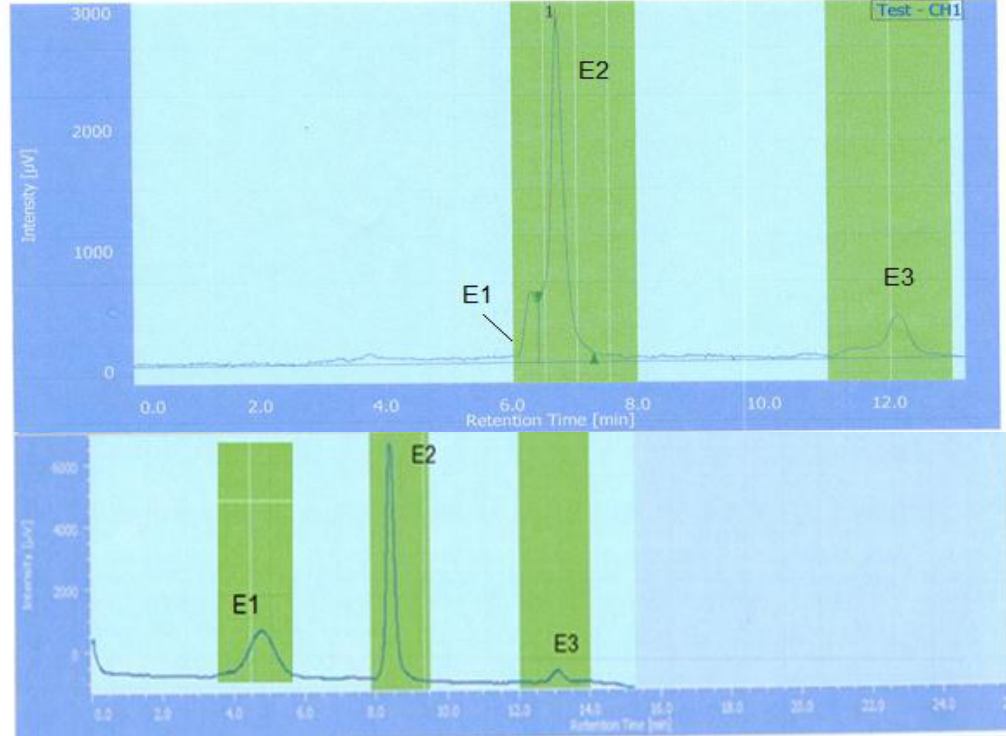
Figure 4: Preparative HPLC analysis of fraction-1 obtained from seeds plant observing three peaks represent three different compounds, one of them (E2) is a major one. Three samples obtained from preparative HPLC were weighted and subjected to co-TLC .Weight of E1 = 0.07 gm , weight of E2 = 0.5 gm, weight of E3 = 0.16